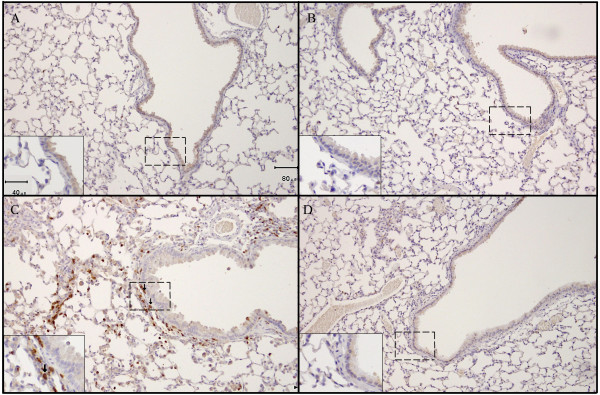
Neutrophil influx into lungs of A/J mice in response to sub-chronic V2O5. Neutrophils were detected by immunohistochemical staining using an anti-mouse neutrophil antibody in formalin fixed lung sections. A.) PBS-treated A/J mouse; B.) PBS-treated B6 mouse, C.) V2O5-treated A/J mouse, 1 day; D.) V2O5-treated B6 mouse, 1 day. Original magnifications ×100, insets ×200. Arrows indicate areas with positive staining for neutrophils (red-brown in color), dashed boxes indicate areas magnified within the insets.